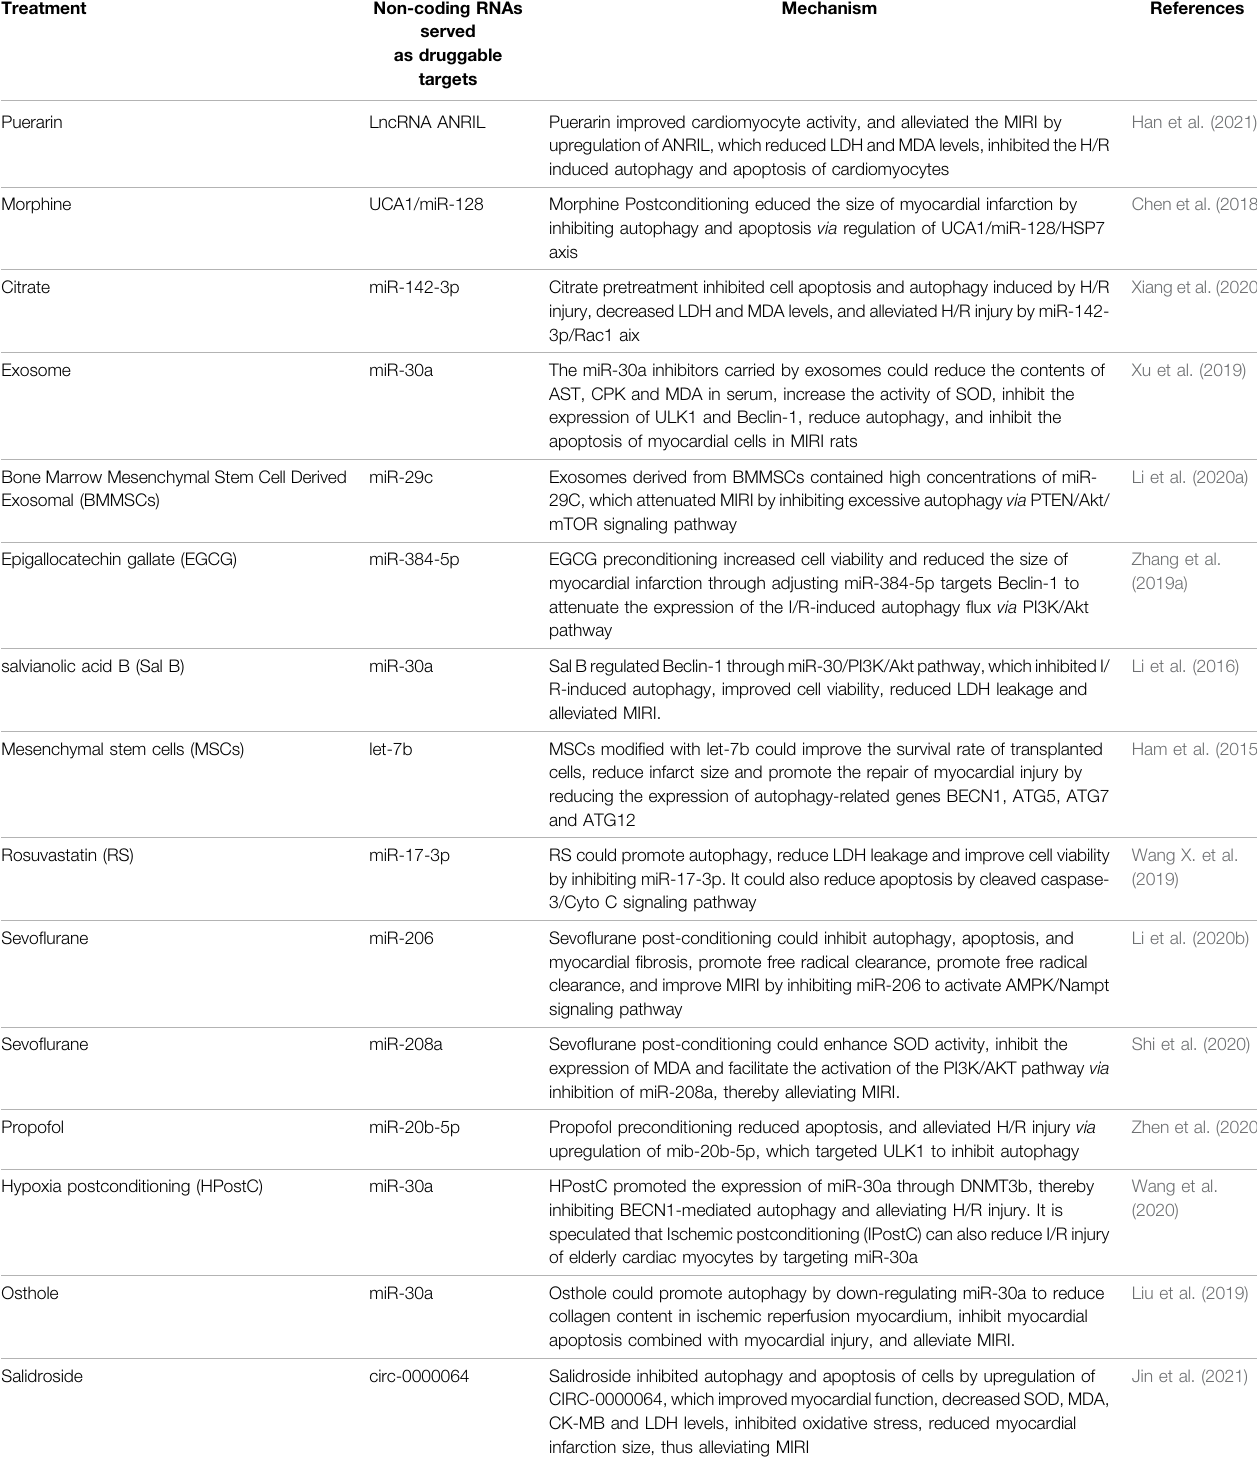
TABLE 1 | Therapies for treating MIRI by targeting non-coding RNAs to regulate